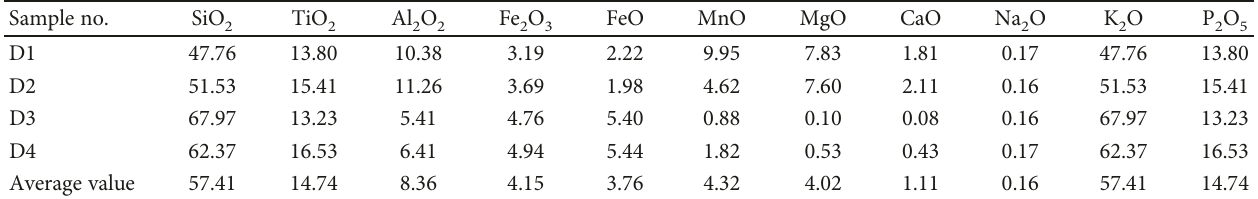
Table 5: Chemical composition percentage of rock samples around the Jinjiang and Julong hot springs. Sample no.